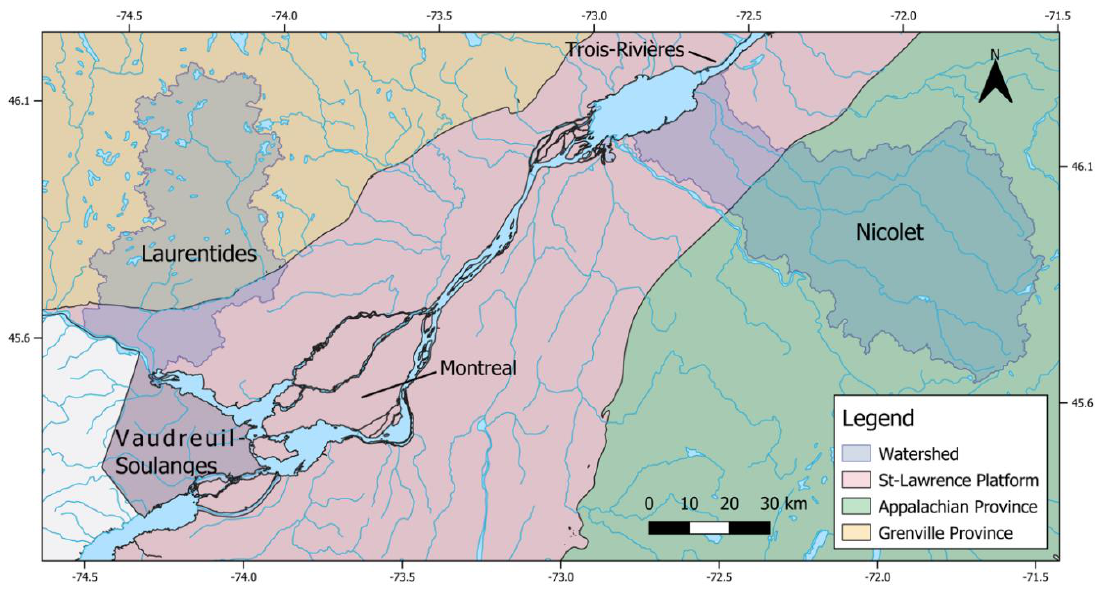
Figure 4. Location of the three selected watersheds (area#1: Laurentides, area #2 Nicolet, and area #3 Vaudreuil–Soulanges).